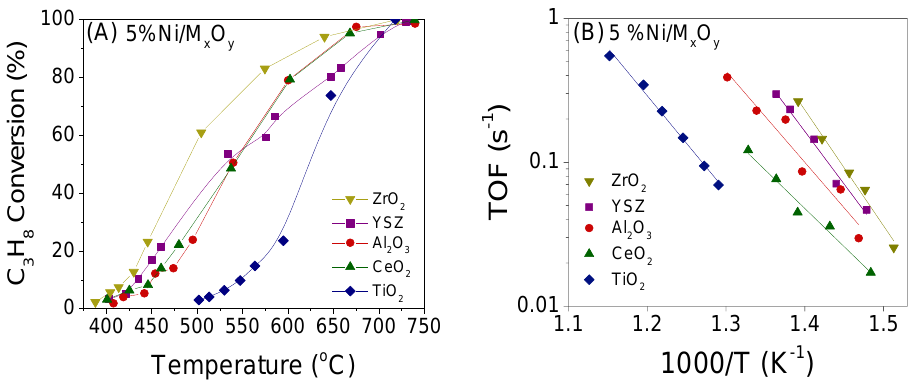
Figure 3. ( A ) Conversions of C 3 H 8 as a function of reaction temperature and ( B ) Arrhenius plots of turnover frequencies of C 3 H 8 conversion obtained over Ni catalysts (5.0 wt.%) supported on the indicated commercial oxide carriers. Experimental conditions: Mass of catalyst: 150 mg; particle diameter: 0.15 < d p < 0.25 mm; Feed composition: 4.5% C 3 H 8 , 0.15% Ar, 44% H 2 O (balance He); Total flow rate: 250 cm 3 min −1 .